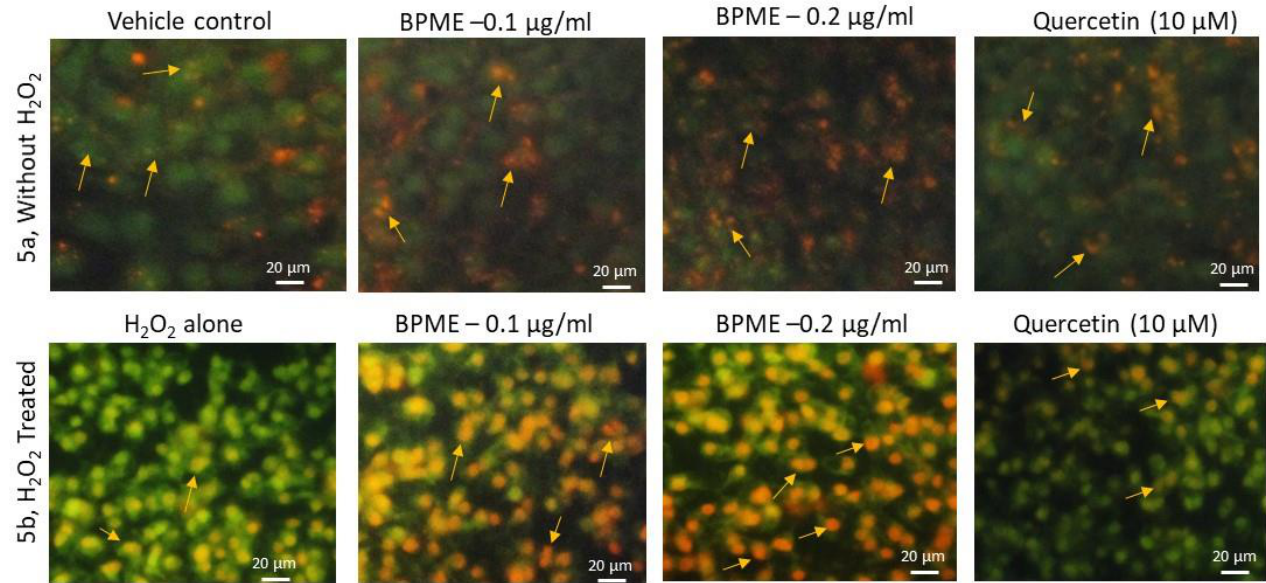
Figure 5. Analysis of mitochondrial membrane potential using JC-1 staining for vehicle control, 0.1 and 0.2 µ g/mL of beetroot peel methanol extract (BPME) treated normal ( a ) and H 2 O 2 -induced oxidative-stressed ( b ) HUVECs after 48 h. JC-1 fluorescence images showing merged images of the red and green signals of the dye, corresponding to JC-1 in J-aggregates vs. monomeric form. We found less J-aggregates H 2 O 2 alone treated HUVECs. In 0.2 µ g/mL BPME-treated HUVECs showing high j-aggregates directly representing (high MMP, ∆ ψ m ) high mitochondrial membrane potential compared to 0.1 µ g/mL of BPME or 10 µ M of